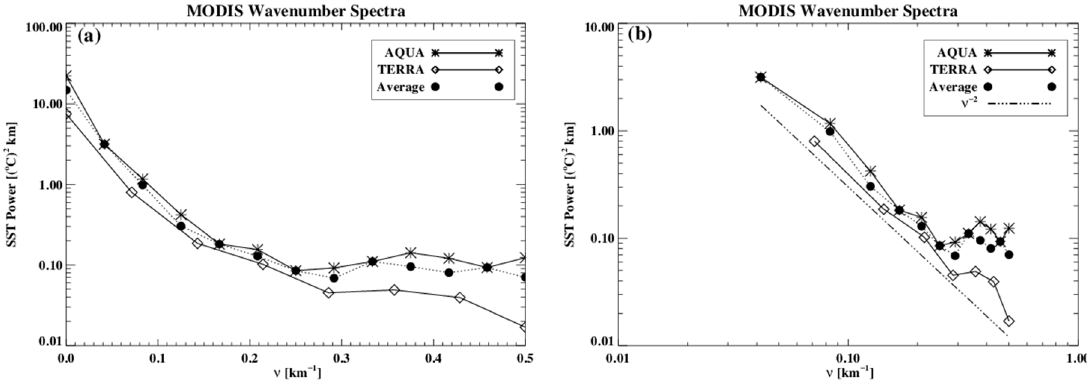
Figure 7. Ensemble-averaged, band-average horizontal wavenumber spectra for SST variance from MODIS, along the ( a ) semi-log and ( b ) log–log axes. MODIS spectra are very nearly proportional to the theoretical spectrum ν − 2 .